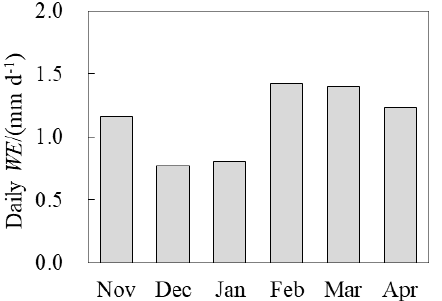
Figure 12. The daily mean surface sublimated water equivalent ( WE ) through the winter of